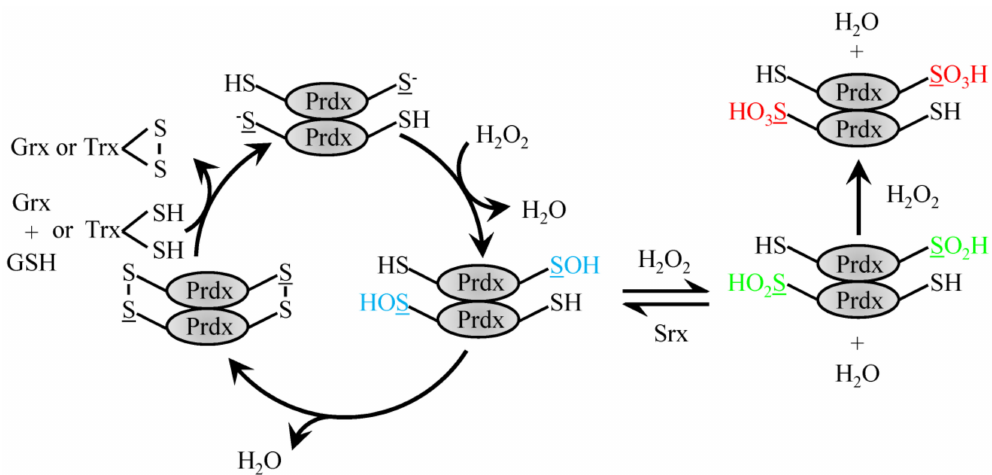
Figure 1. Reduction of H 2 O 2 by typical 2-Cys Prdx. H 2 O 2 recycling by 2-Cys typical Prdx